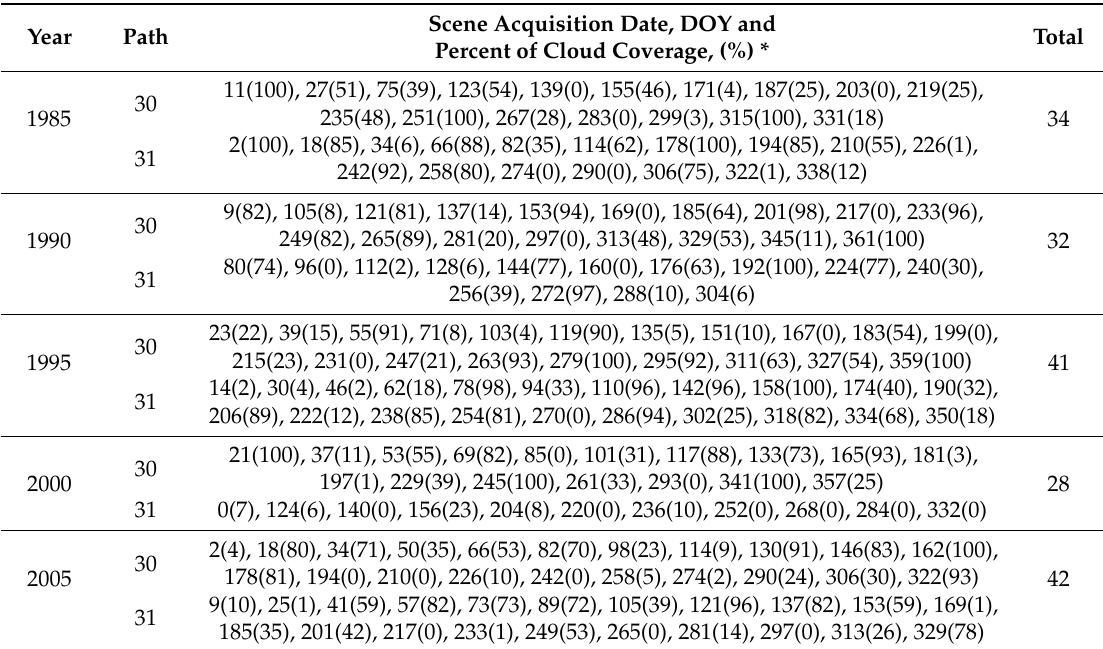
Figure 1. The Lower Bear Creek watershed is located in the northern part of the U.S. ( a ) at the southeast corner of the state of North Dakota ( b ). Field boundaries were digitized using high-resolution aerial photographs combined with the U.S. Department of Agriculture Crop Data Layer datasets ( c ). The watershed is covered by two Landsat TM5 scene footprints ( d ). Table 1. List of Landsat TM5 scenes used per